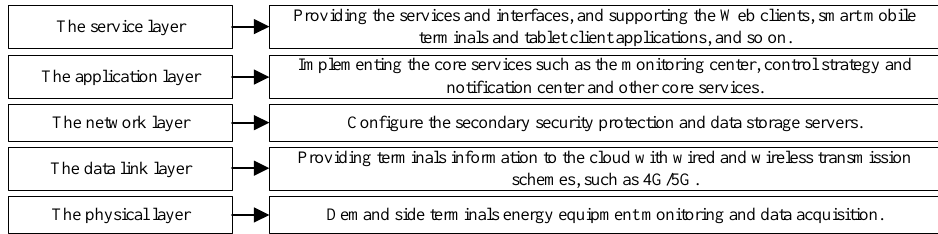
The five-layer framework of information interconnection is shown in Figure 2, in- cluding the physical layer, data link layer, network layer, application layer and service layer, explained as follows.